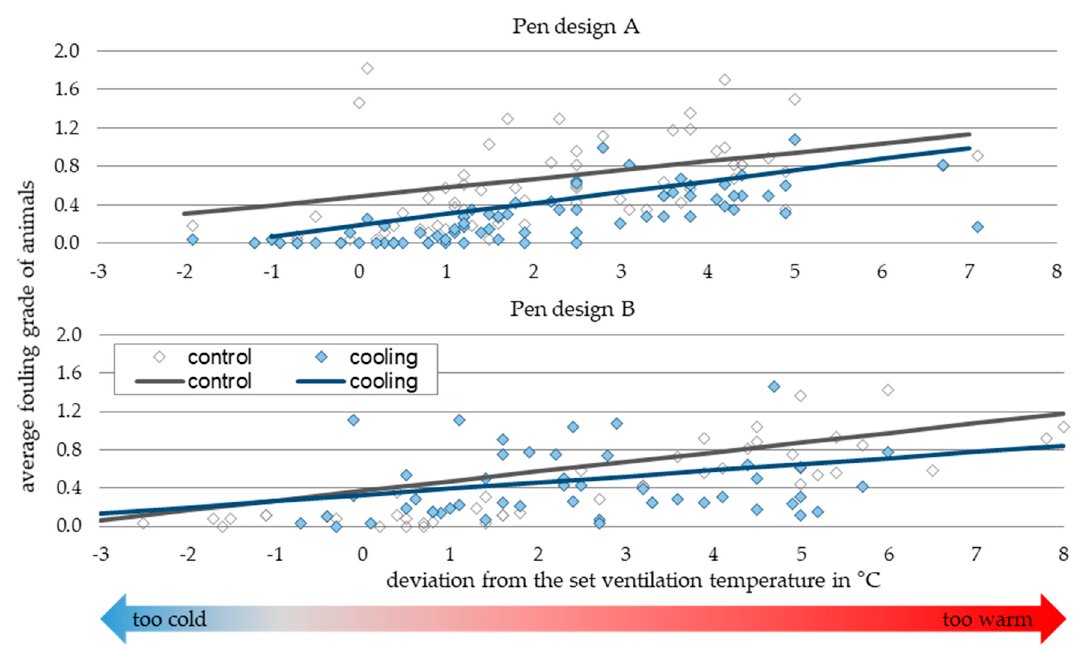
Figure 10. The e ff ect of the deviation from temperature on the average fouling of the animals. Diamonds Figure 10. The effect of the deviation from temperature on the average fouling of the animals. show the single data and the lines shown the trend Diamonds show the single data and the lines shown the trend line.